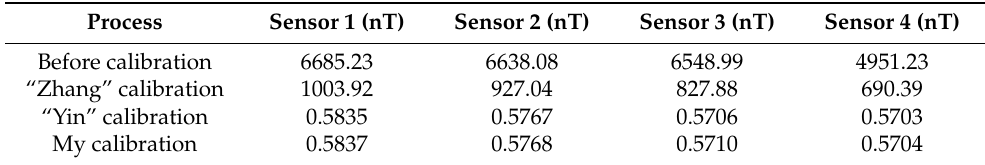
Table 1. Comparison of root-mean-square errors (RMSE) of TMI before and after calibration using the simulation.